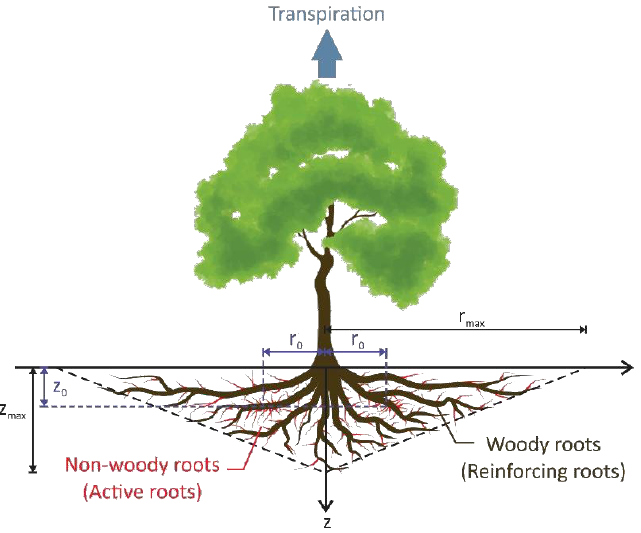
Figure 5. Schematic image of root distribution (modified from [66]).